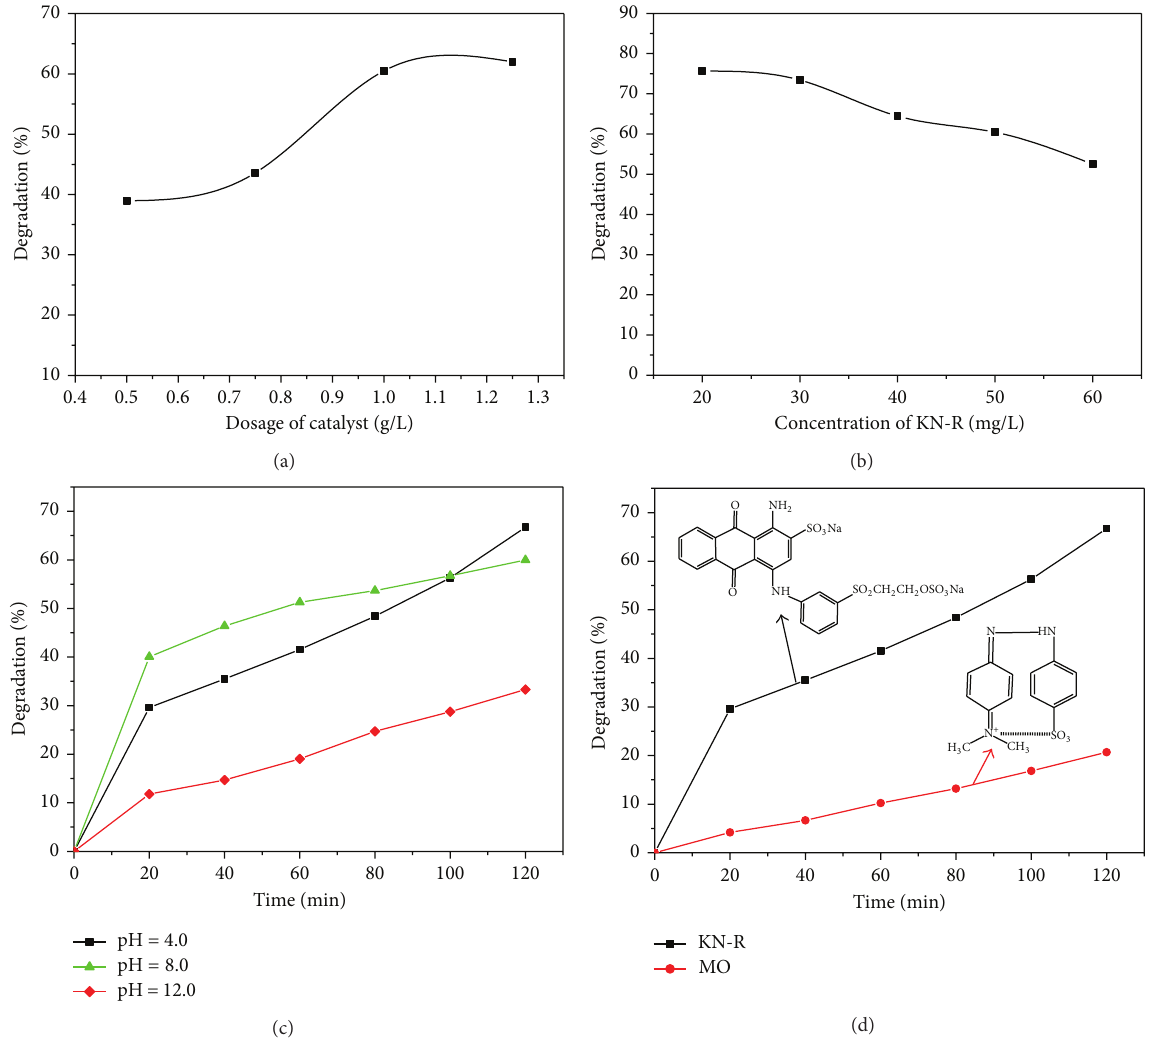
Figure 7: Effect of photocatalyst dosage, initial concentration of dye, and pH value of solution and dye species on photocatalytic reaction.